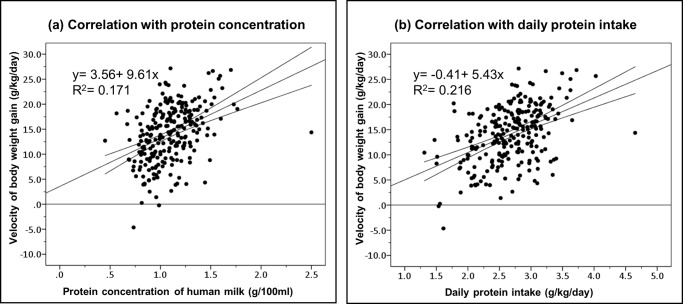
Linear relationship between protein content and body weight gain.The correlation of the velocity of body weight gain with (a) protein concentration in human milk and (b) daily protein intake. Spots in the figure were unadjusted values. The simple linear regression equation is indicated by the straight line. The upper and lower curves represent the 95% confidence interval of the mean.